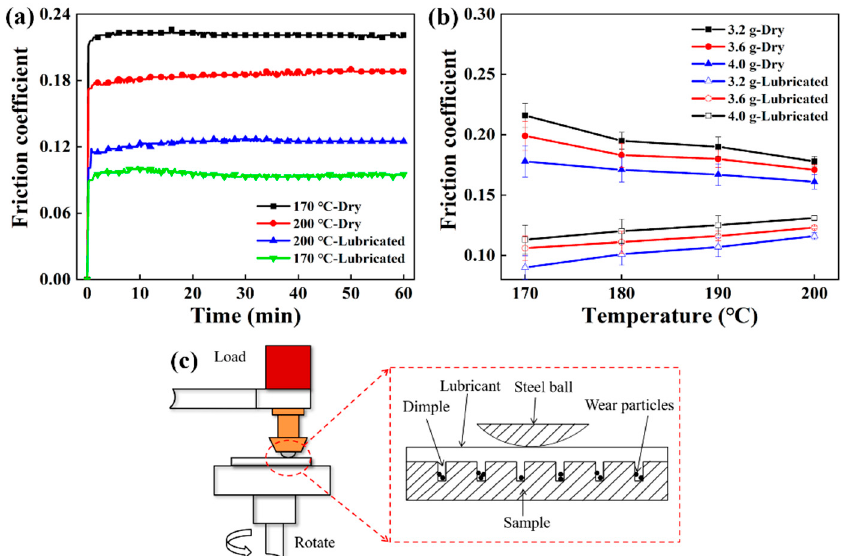
Figure 8. The friction and wear performance comparison of the samples: ( a ) The friction curve of the sample under different porosity and working conditions when the charging amount was 3.2g, ( b ) coefficient of friction of samples under different porosity and working conditions, and ( c ) schematic diagram of friction and wear under different working conditions.